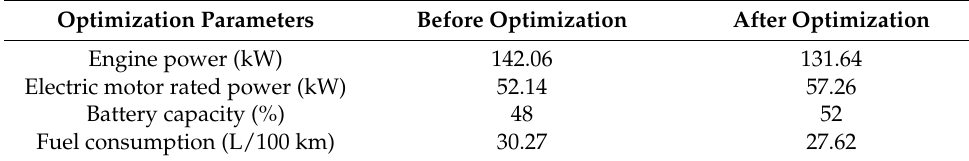
Figure 9. Comparison of emissions depending on different power requests. Table 4. Comparison of parameter matching optimization